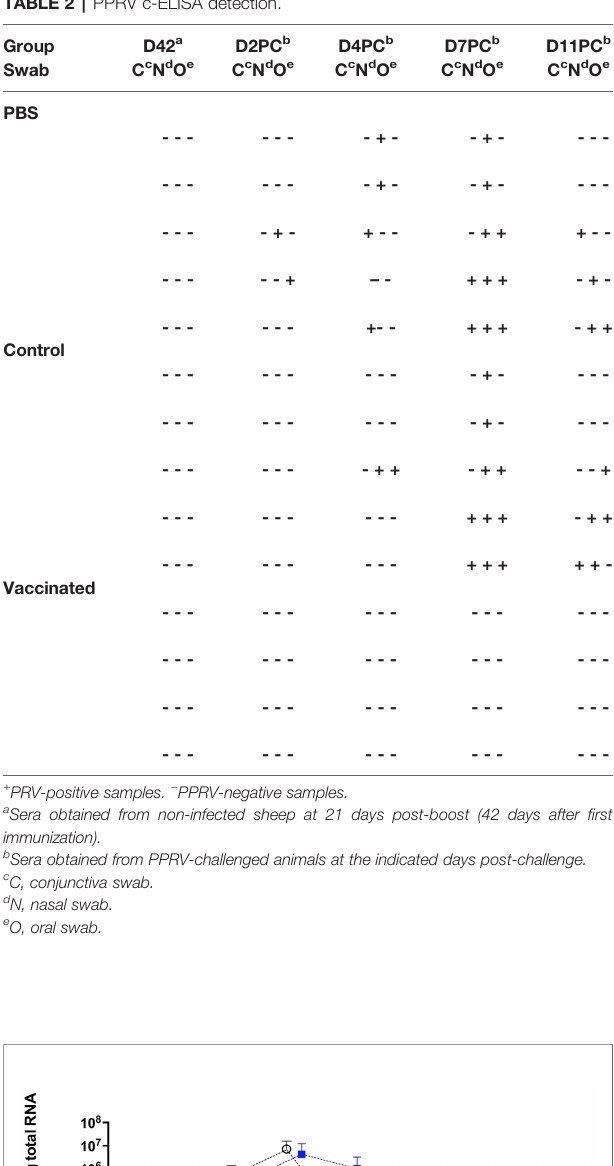
TABLE 2 | PPRV c-ELISA detection.